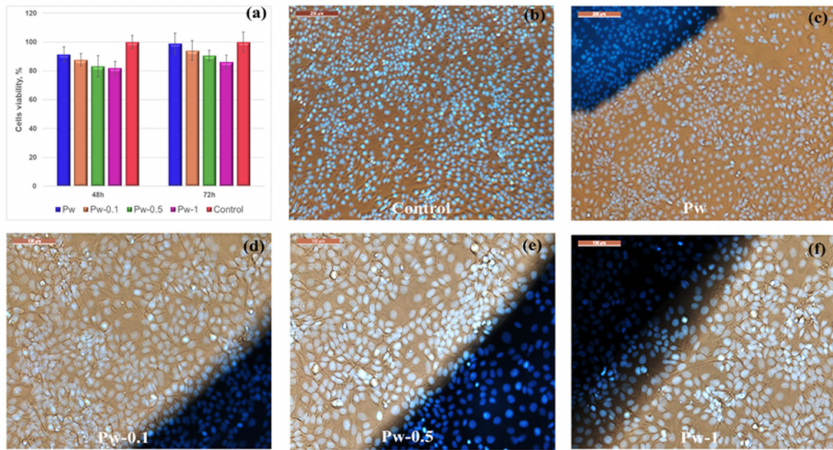
Figure 12. Evaluation of cytotoxicity: ( a ) MTT assay and ( b – f ) morphological visualization of epithelial cells after 72 h direct contact with PU-based composite membranes prepared in wet conditions with different amounts of